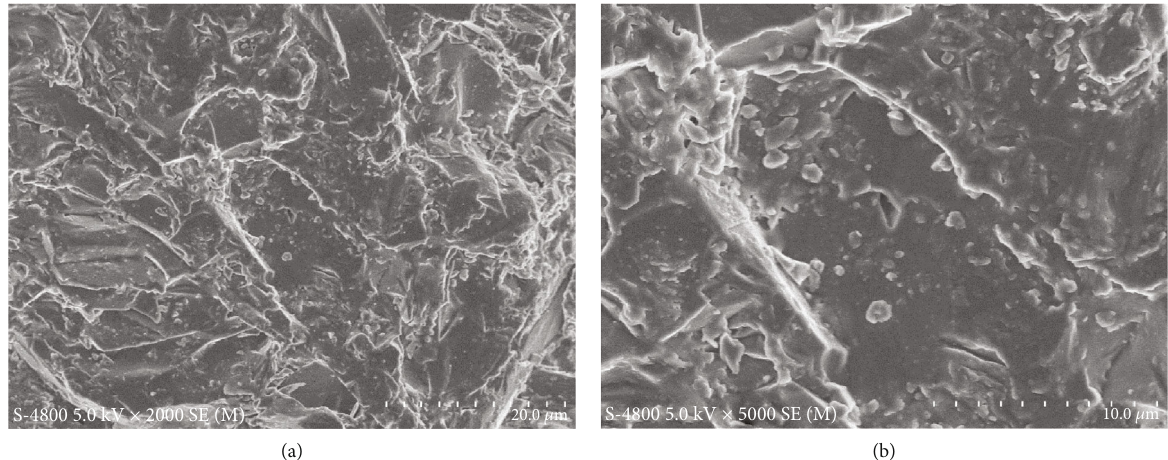
Figure 2: SEM results for granite with di ff erent magni fi cations. (a, b) Plots of the SEM results with magni fi cations of 2000 and 5000 times, respectively.